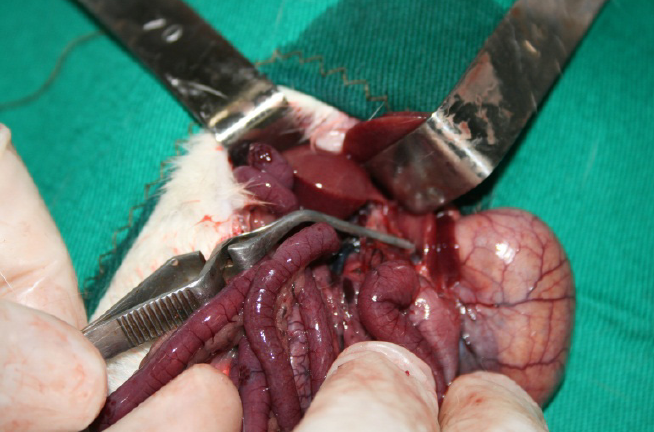
FIGURE 1 - Details of the hepatic pedicle clamping to induce total hepatic ischemia by applying a Bulldog vascular clamp in group 2 (Ischemia/reperfusion) rats.